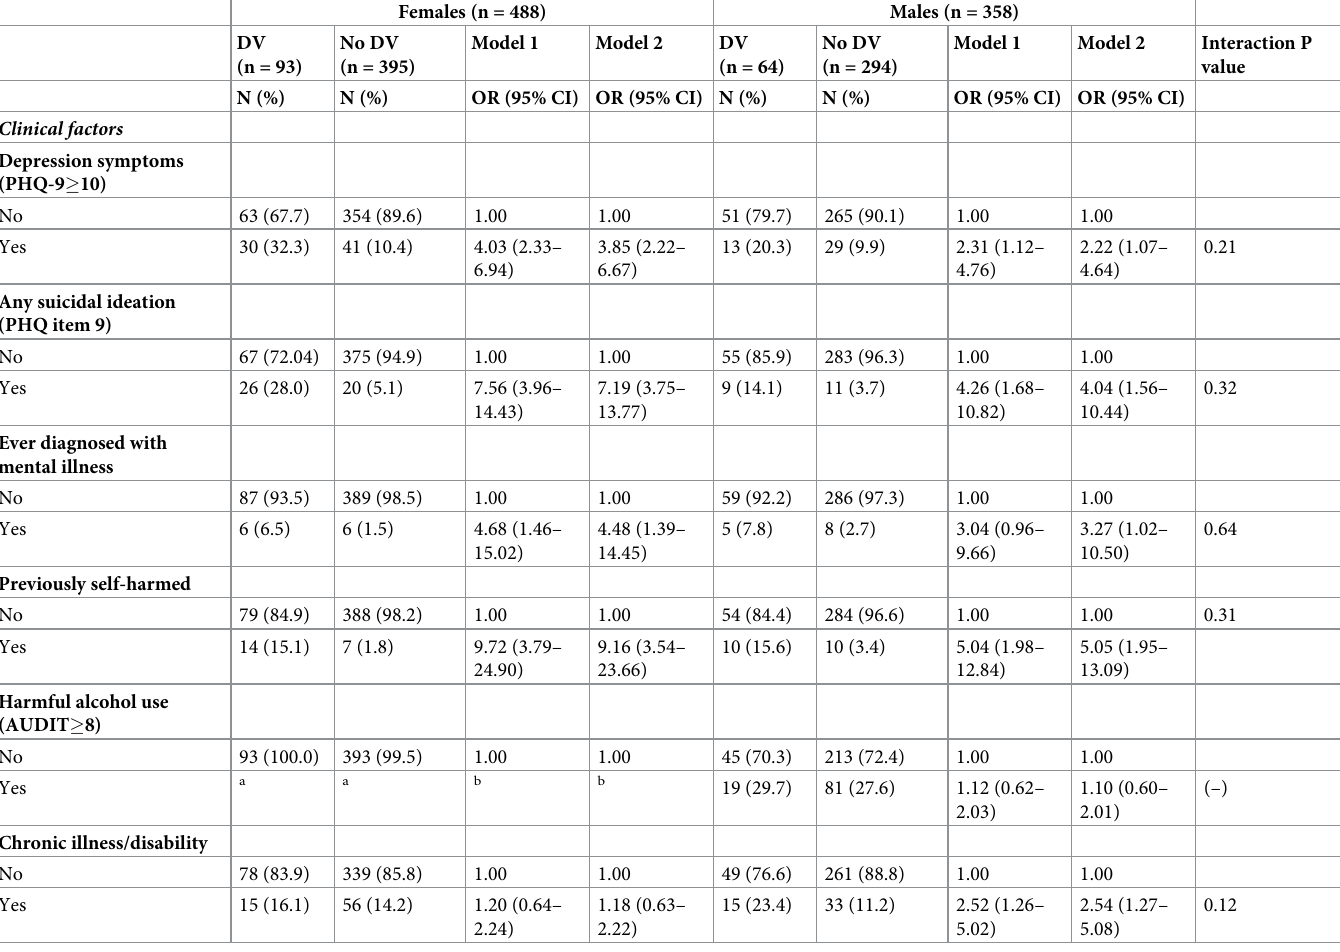
Table 3. Clinical factors associated with domestic violence (DV) in Kandy, Sri Lanka, stratified by